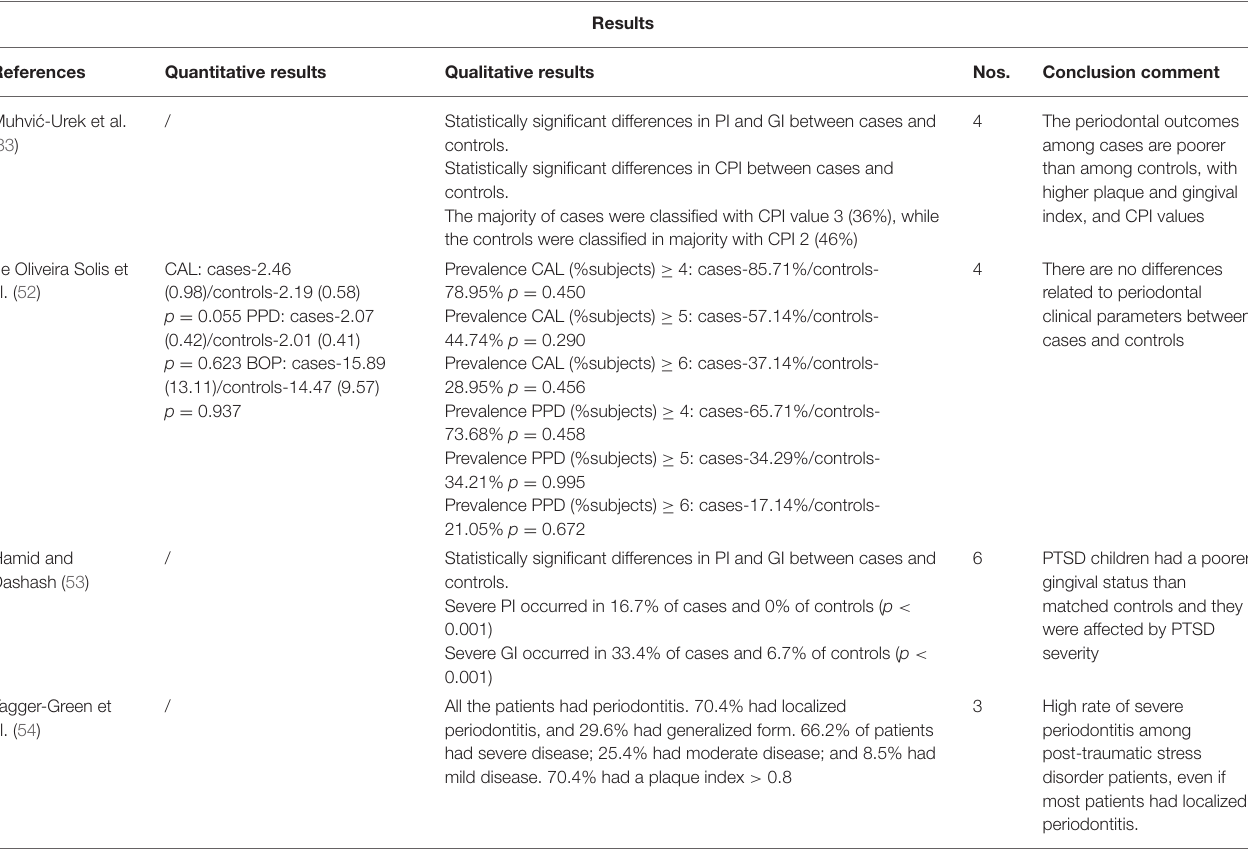
TABLE 2B | Methodology and outcomes of publications studying the relationship between trauma-associated stress and